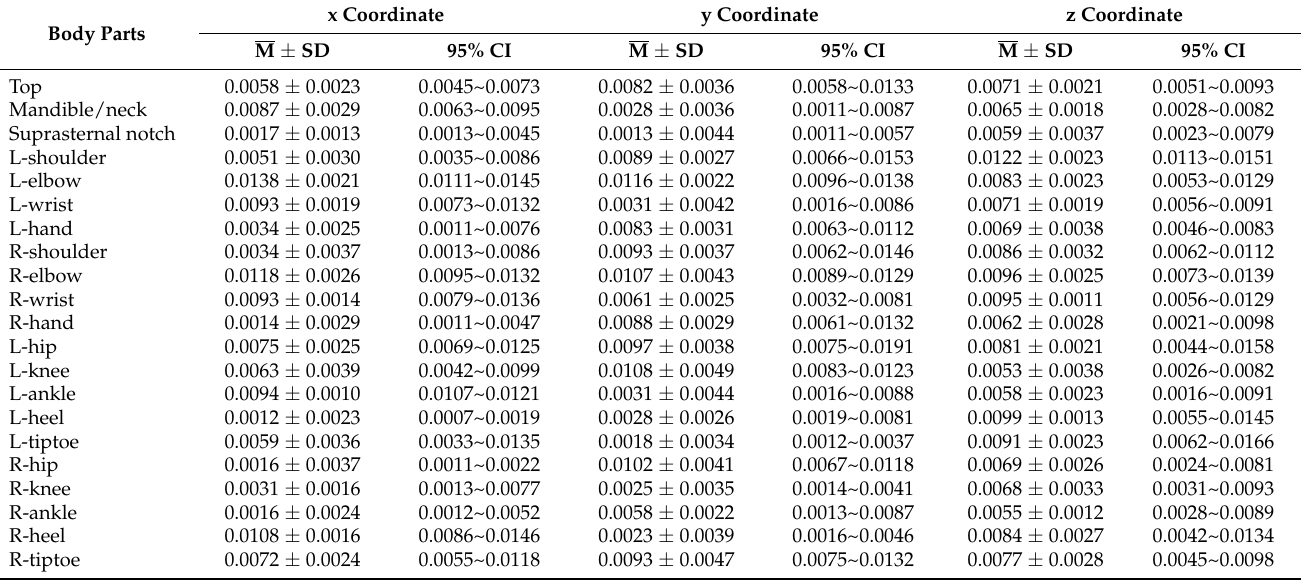
Table 4. Difference between the average human joint point coordinate–time curve obtained via automatic analysis and manual analysis (m).